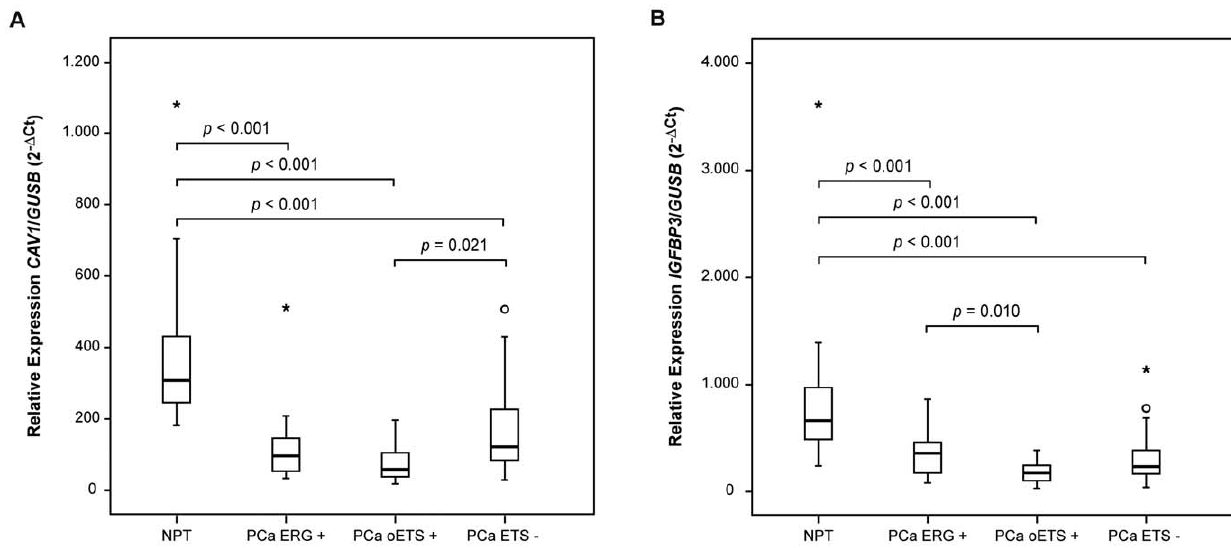
Figure 2. Box-plot distribution of CAV1 and IGFBP3 expression in PCa sample subgroups. A) CAV1 expression; B) IGFBP3 expression. A p value is shown whenever the differences in each two group comparison reach significance ( p , 0.05).